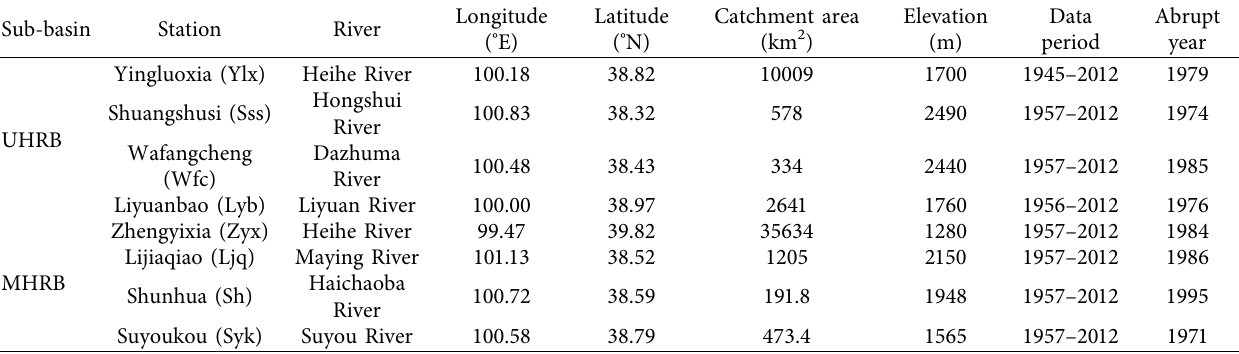
Table 2: Information on the hydrological stations.